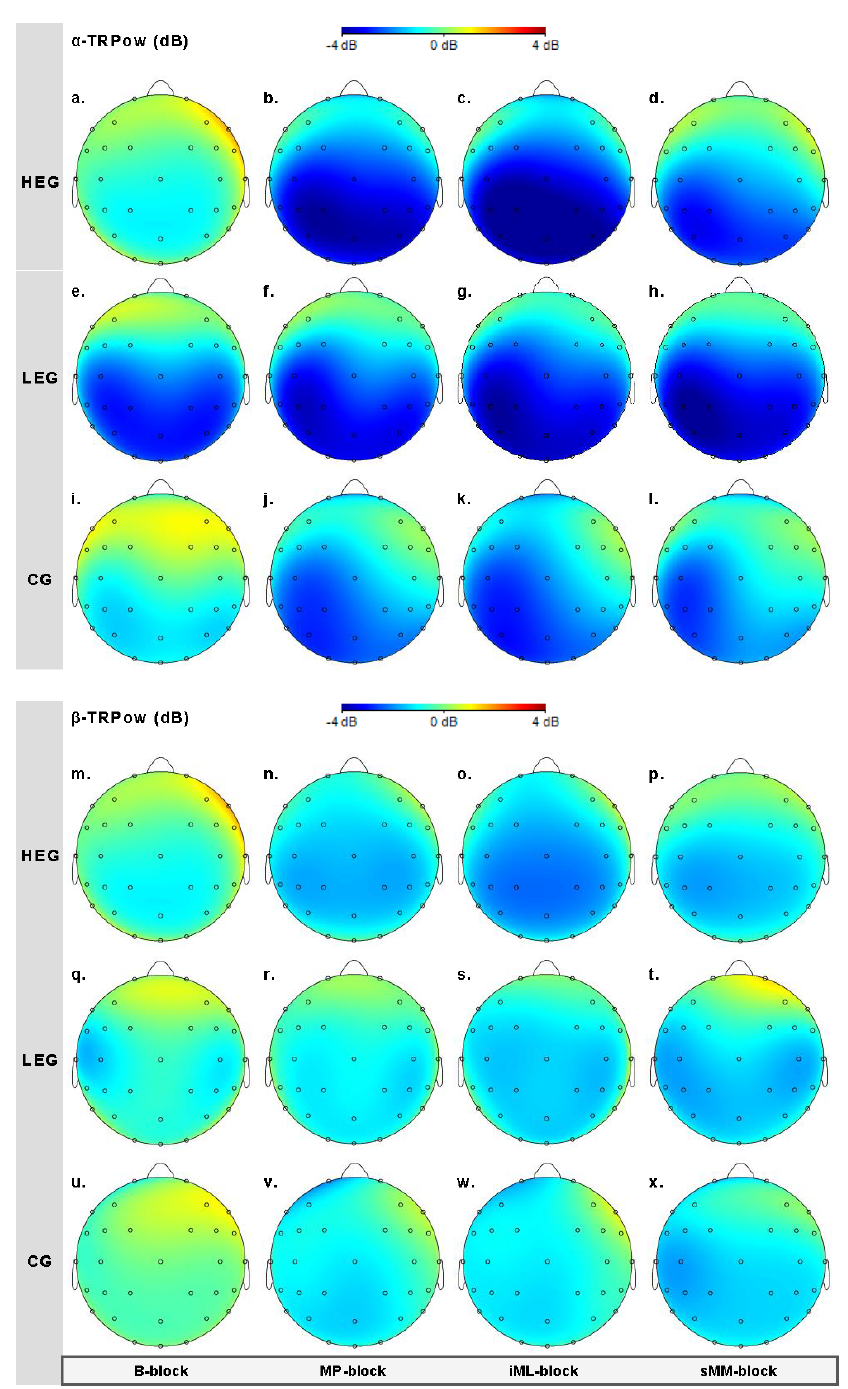
Figure 6. EEG scalp maps of α - and β -TRPow (dB) for the high-intensity exercise group (HEG), low-intensity exercise group (LEG), and control group (CG) over the 4 measurement blocks included in the statistical analyses ( B-block: baseline; MP-block: motor performance; iML-block: initial motor learning; sMM-block: short-term motor memory).